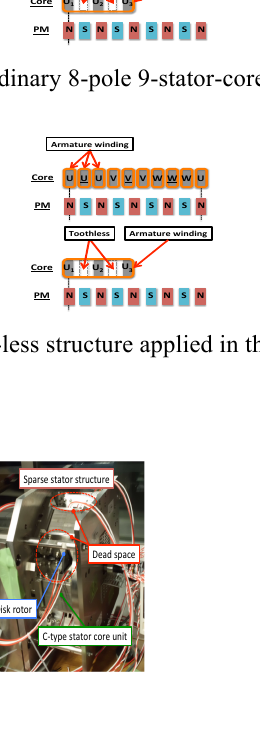
Figure 3: Structure of the previous experimental machine.